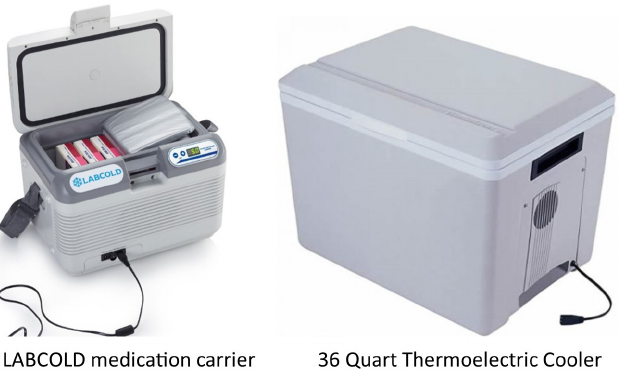
Figure 1. Examples of an existing specimen transport box for a hospital laboratory